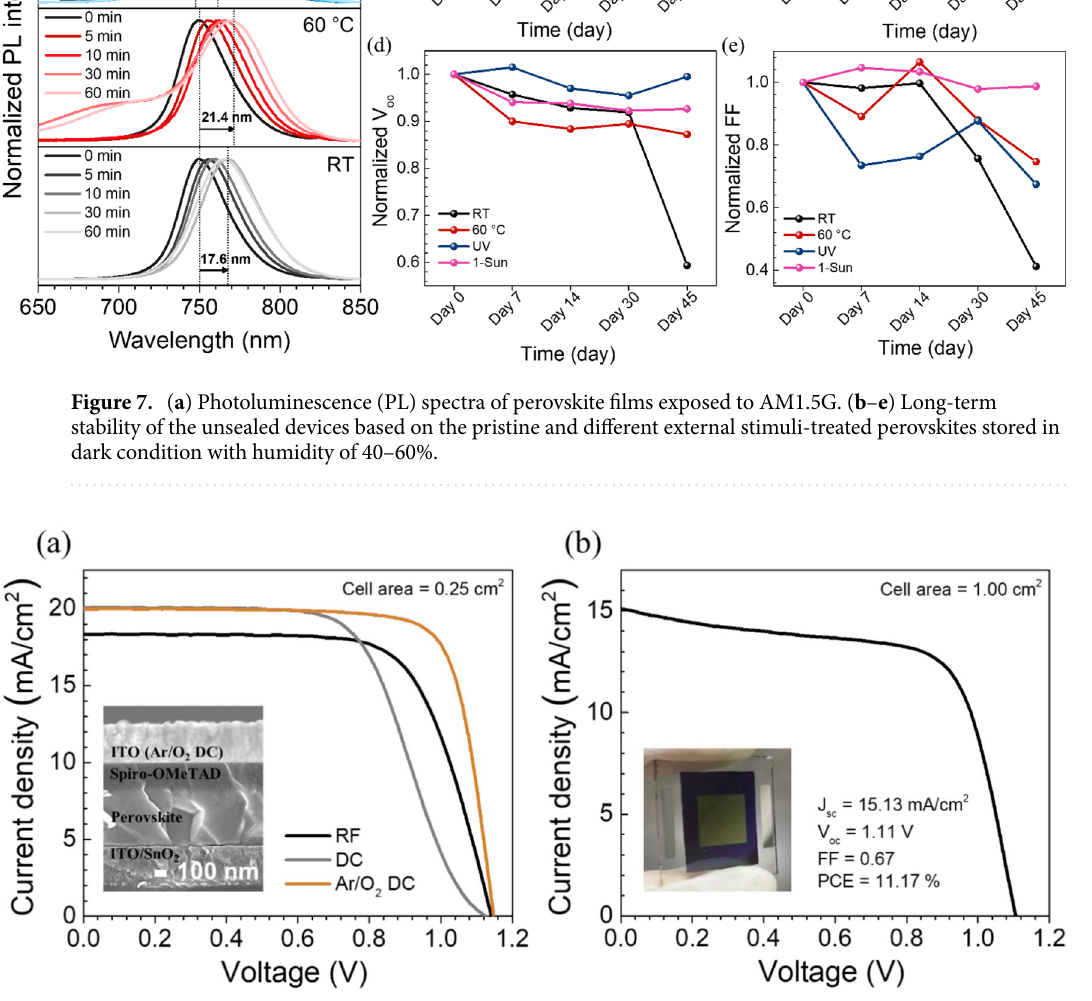
Figure 8. ( a ) J-V curves of semi-transparent perovskite solar cells with different ITO electrodes (cell area = 0.25 cm 2 ). The inset shows the cross-sectional SEM of the device architecture. ( b ) J-V curve of semi-transparent perovskite solar cell with the cell area of 1.00 cm 2 . The inset shows the actual solar device with the active area 1.00 cm 2